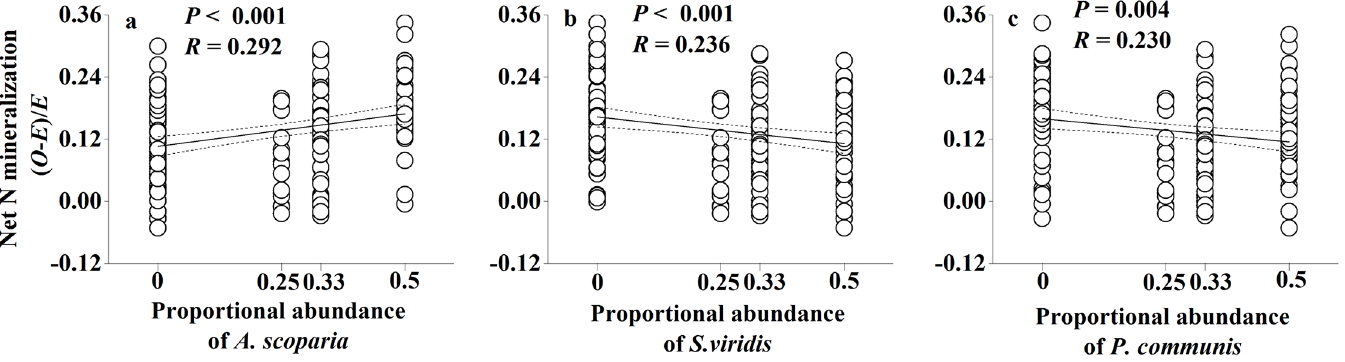
Fig 6. Non-additive soil net N mineralization responses to mixed-species litter as a function of individual species abundance of A . scoparia , S . viridis and P . communis within the litter mixtures. Dashedlines represent the 95% confidenceinterval of the regression. O : observedvalues; E : expected values. n.s.: not